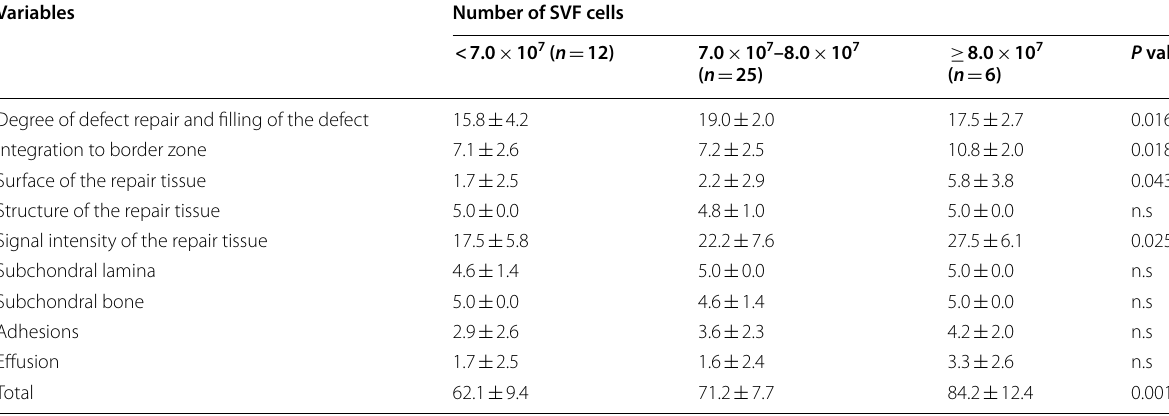
Data are presented as means standard deviation ± MOCART Magnetic resonance observation of cartilage repair tissue, SVF Stromal vascular fraction * Kruskal–Wallis test